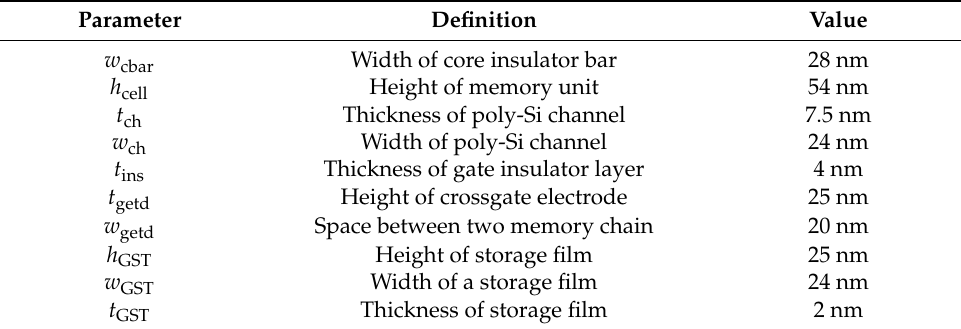
Table 1. Geometric parameters of the PCM cells and arrays.